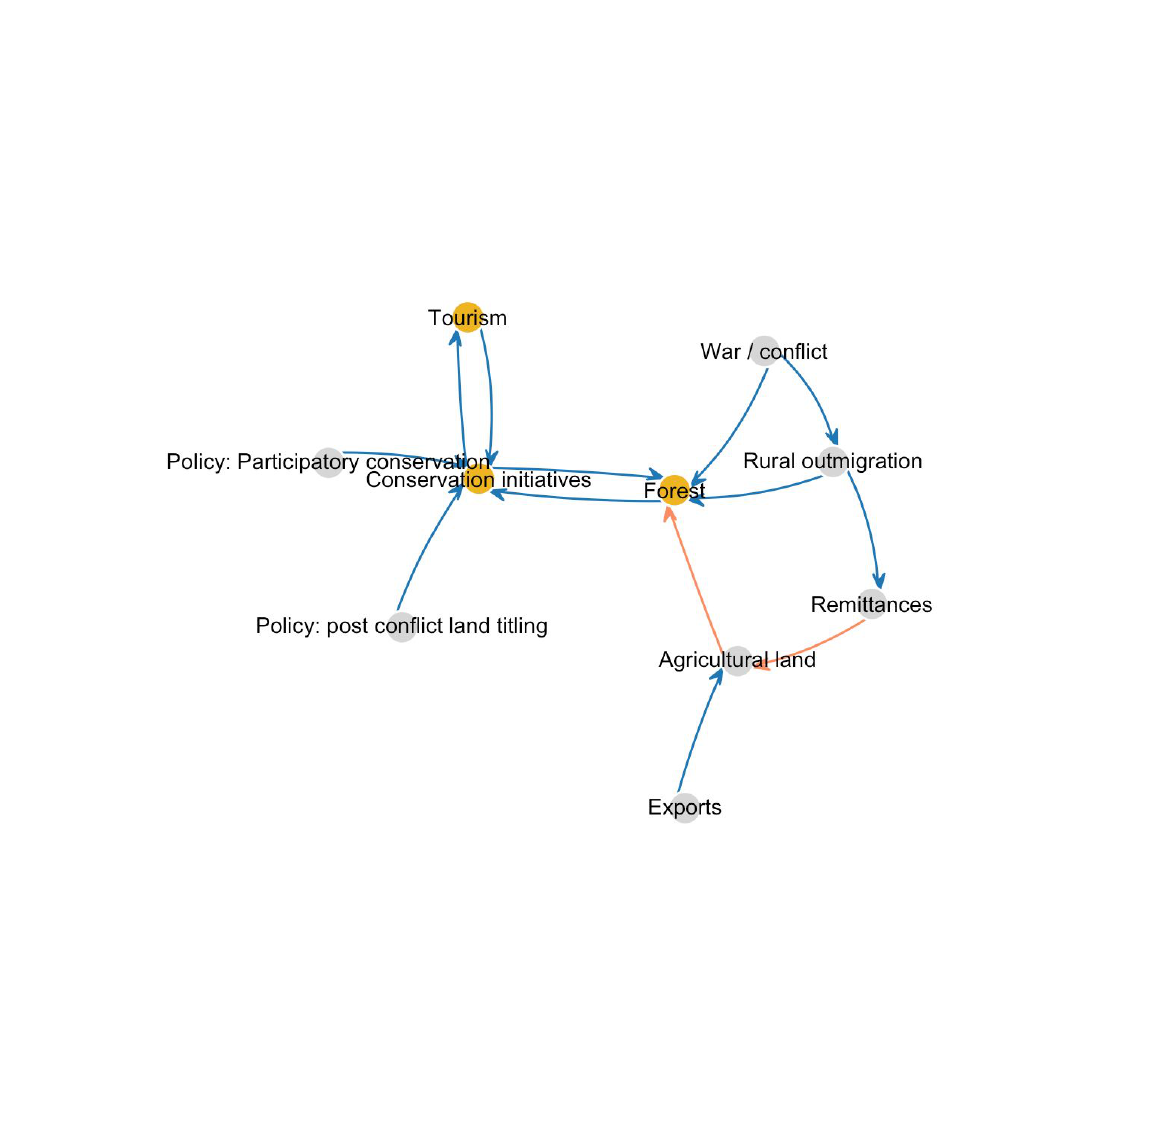
Figure A1.1. CLD Forest resurgence in post-war El ​​